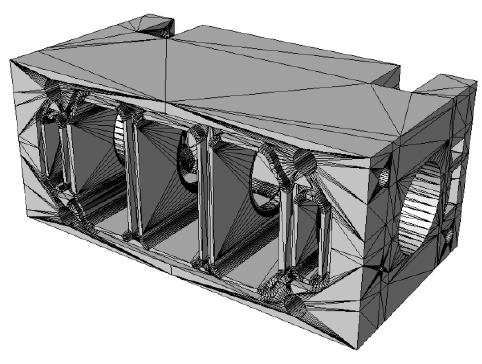
Figure 9. STL model.